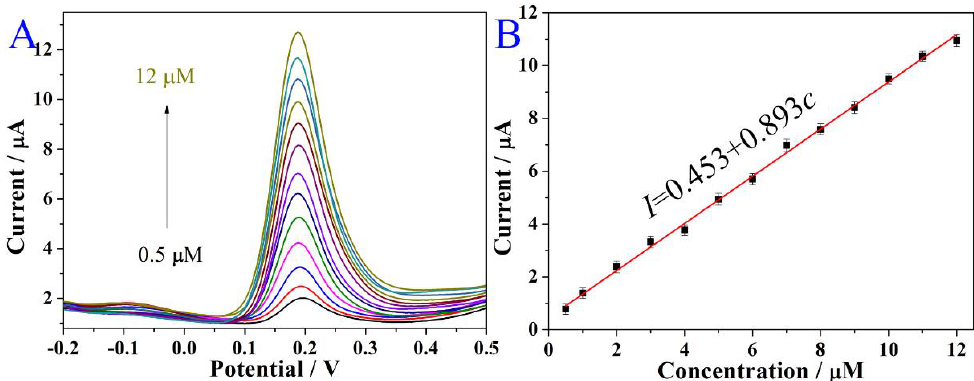
Figure 8. The SWV of sensor in different concentrations of QR from 0.5 to 12 μM ( A ) and their calibration curve of concentration and current ( B ).